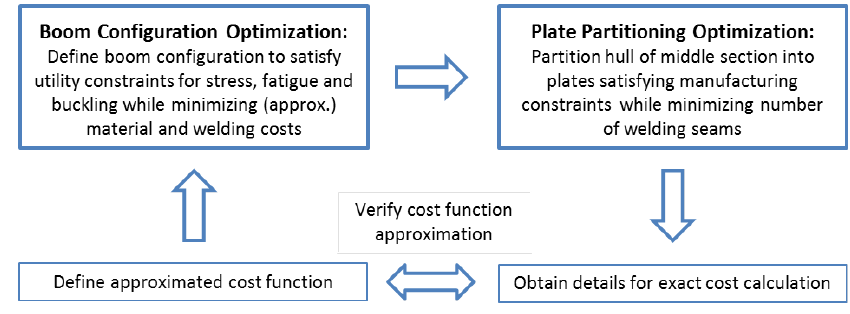
Figure 4. Steps of the Box-Type Boom